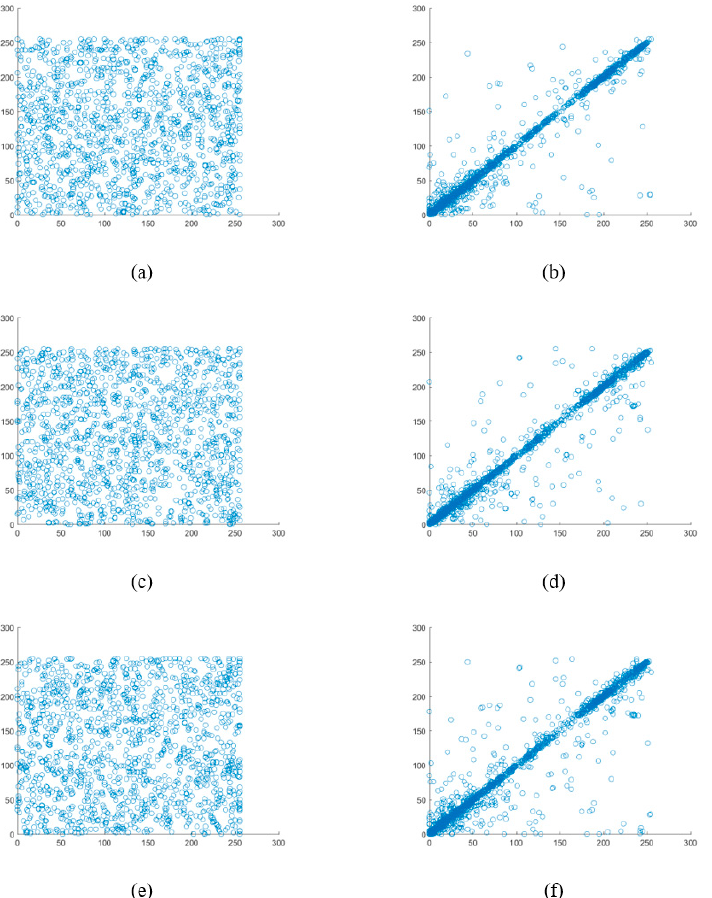
Figure 10. Correlation analysis. ( a ) Horizontal correlation of encrypted image; ( b ) Horizontal correlation of baboon image; ( c ) Vertical correlation of encrypted image; ( d ) Vertical correlation of baboon image; ( e ) Diagonal correlation of encrypted image; ( f ) Diagonal correlation of baboon image. The correlation coefficients calculated by Equation (28) are demonstrated in Table 1.